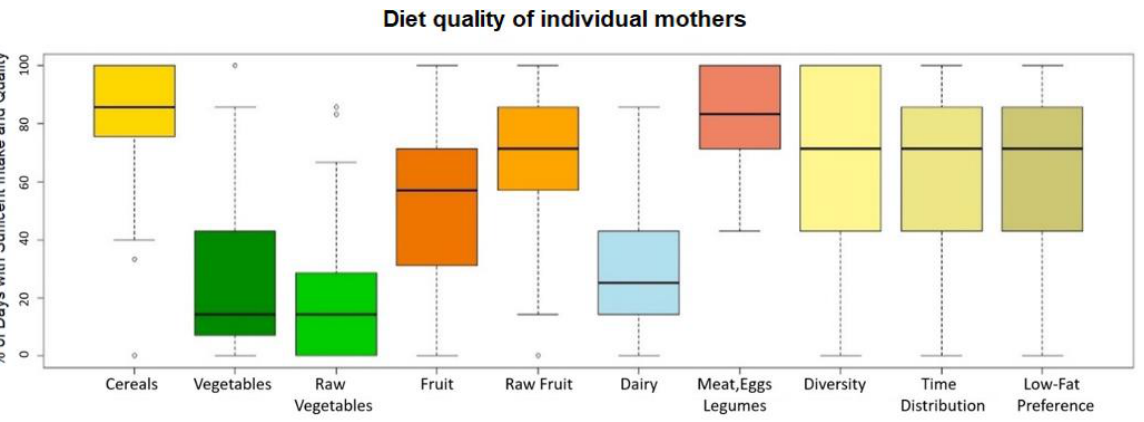
Figure 2. Diet quality of individual mothers. The average maternal overall diet quality ranged from 2.3 to 9 points out of a maximum of 10